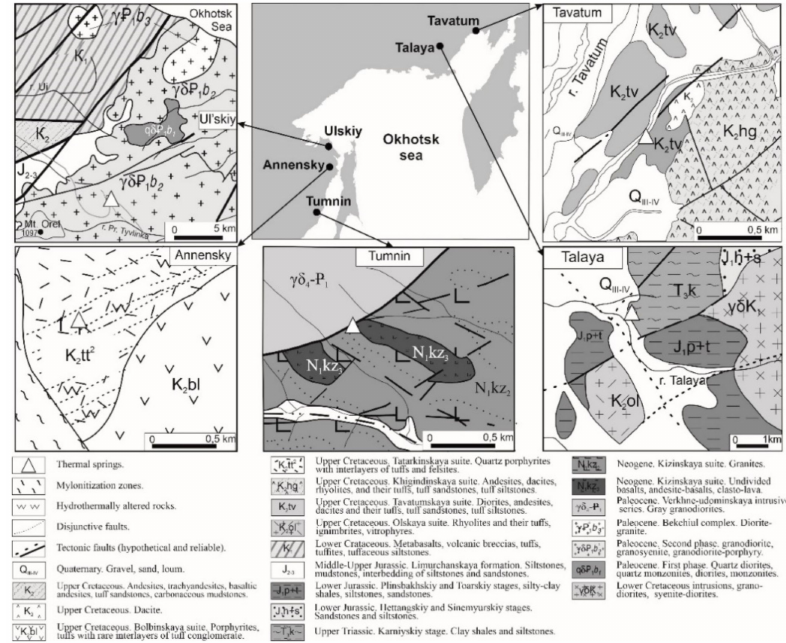
Figure 2. The geological conditions of the studied thermal